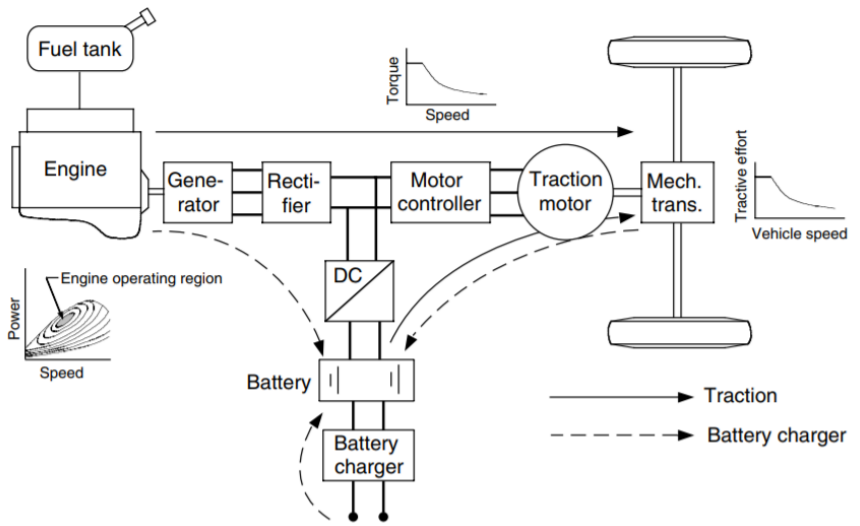
Figure 6. Series hybrid configuration [35].